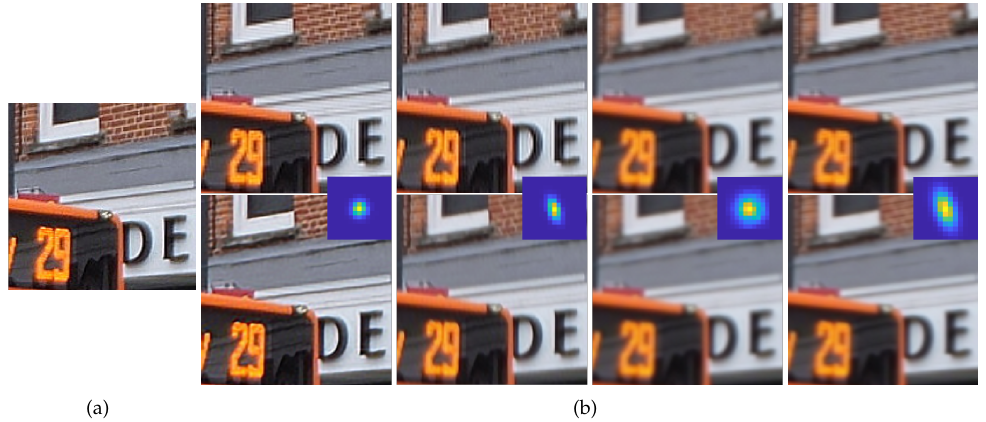
Figure 2. SR results comparison using blurring kernels in scale factor × 2. ( a ) GT, ( b ) the first row shows the results of solving Equation (2) and the second row shows the results of [13]. The input images of each column are degraded, respectively, from GT using the different blurring kernels shown in the middle of each columns. However, in the SR process, both SR methods assumed the same Gaussian kernel as a blurring kernel to investigate the effects of different